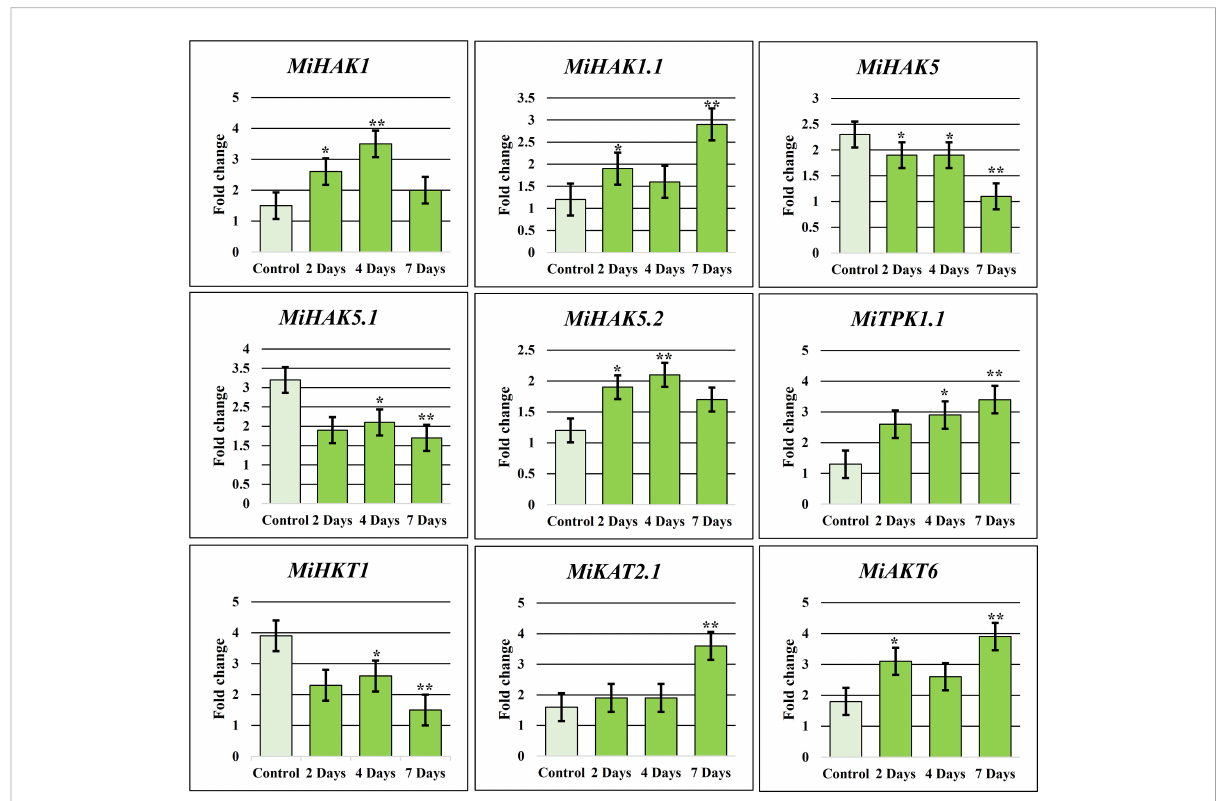
FIGURE 6 K + transporting gene family relative qRT-PCR in response to drought. To produce an objective average value, the experiment was triplicated. In untreated plants, each gene had a default expression value of 1. Bars have been placed on each column to illustrate the standard error. *denotes signi fi cant differences between environmental stressors and the control (p 0.05), whereas **denotes extremely signi fi cant differences (p